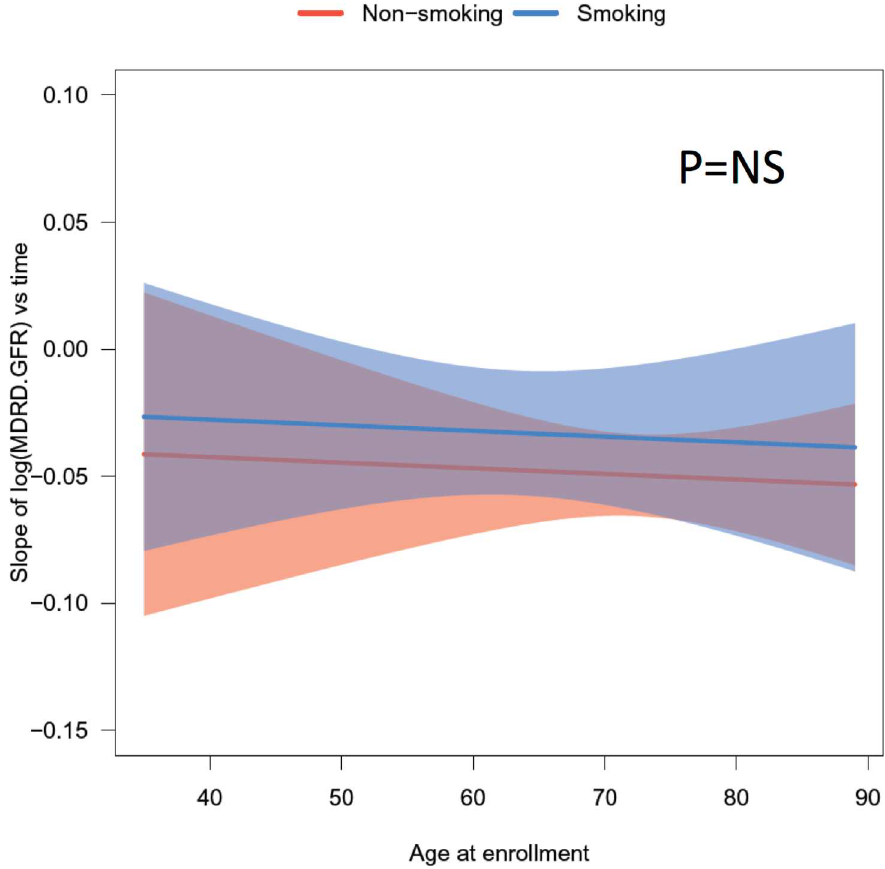
Fig 5. Fitted longitudinal slope of the natural log of MDRD-GFR over time-in-study by age at enrollment. For each individual, the longitudinalslope of MDRD-GFR was obtainedby linear regression betweenthe log of MDRD-GFR and time-in-study for that patient. These slopes were used as the response variableand fitted into a multiplevariableregressionmodel with age, sex, ethnicity, smoking, diabetesand BMI as covariates. The plot of the predicted slope of MDRD-GFR over time with 95% confidenceintervals was generatedfor age at enrollmentgroupedby smoking status (red for smokers and blue for non-smokers).